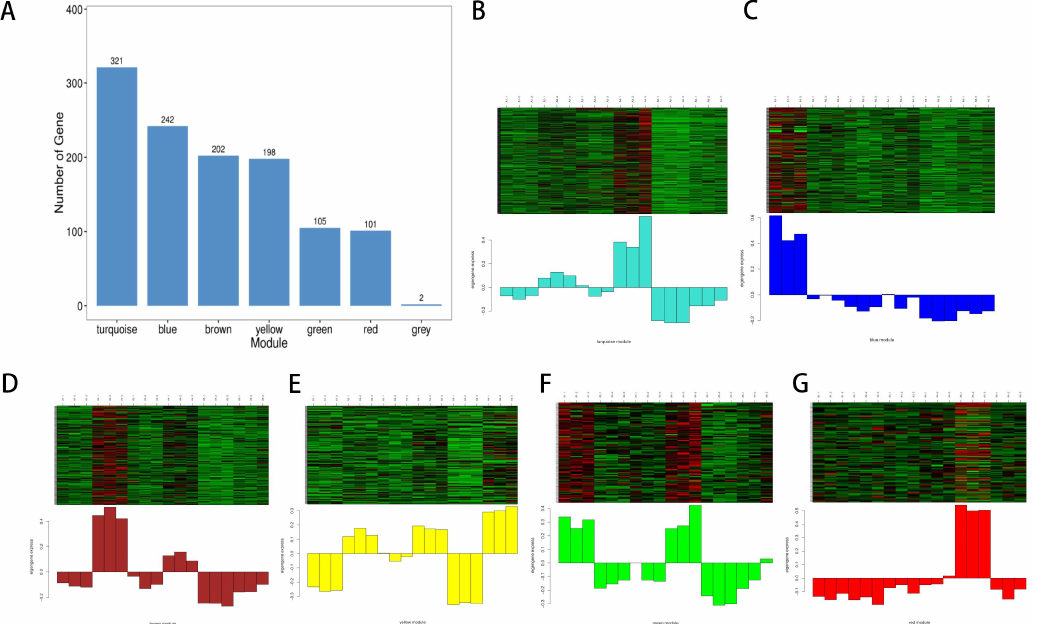
Figure 8. Heat map of metabolite numbers and expression by module. ( A ) Histogram of the number of genes in each module, with the horizontal coordinate indicating each module and the vertical coordinate indicating the number of genes. ( B – G ) Heat map of gene expression patterns by module, the expression patterns of each gene contained in each module are presented in a heat map, and the changes in module characteristic values across samples (equivalent to module expression patterns) are presented in a bar chart. In the figure, the top half is the heat map of the expression of genes in the modules in different samples, with up-regulation in red and down-regulation in green; the bottom half is the module characteristic values in different